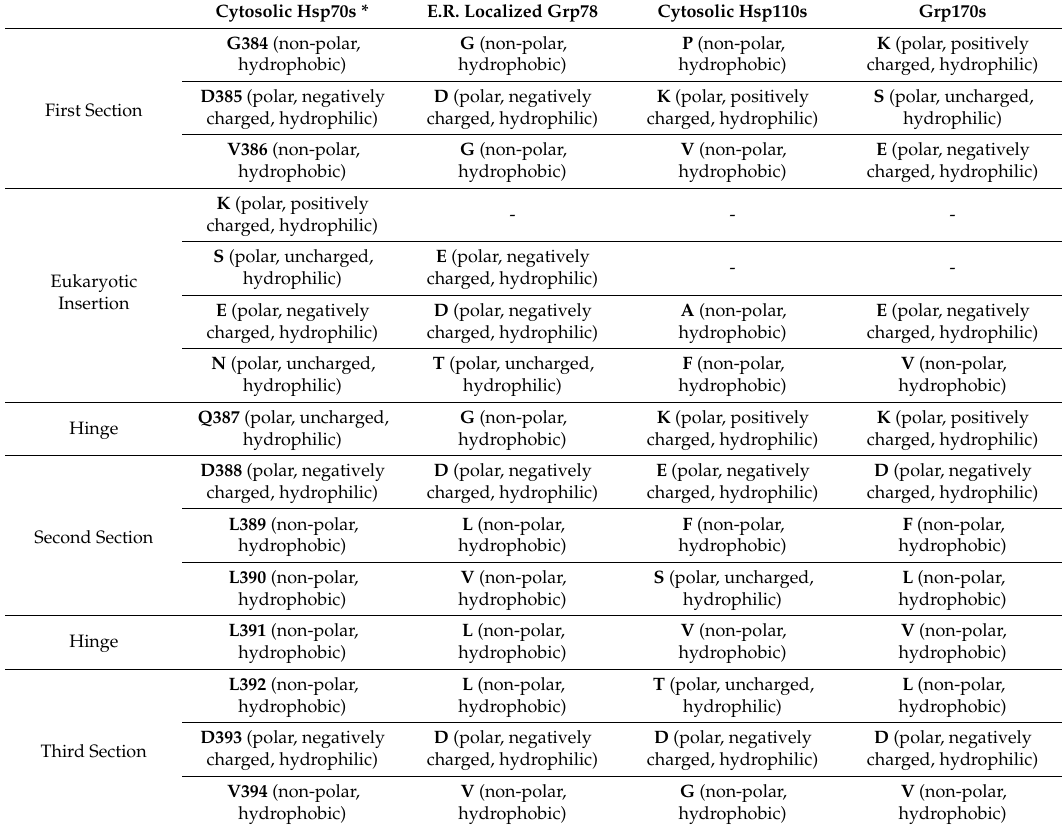
Table 1. Properties of Amino Acid Residues of Linkers of Canonical